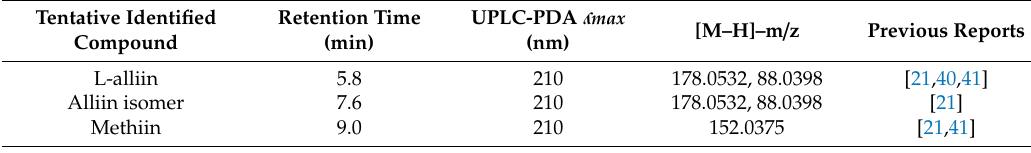
Table 3. Content of phenolic acids and anthocyanins in the garlic samples studied.